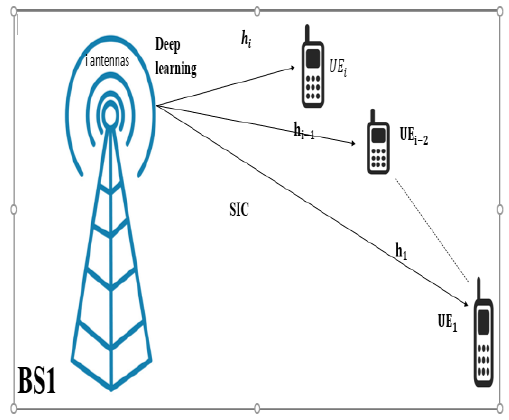
Figure 4. Multi-user OPA using DNN-MIMO-NOMA along with DLS Algorithm.